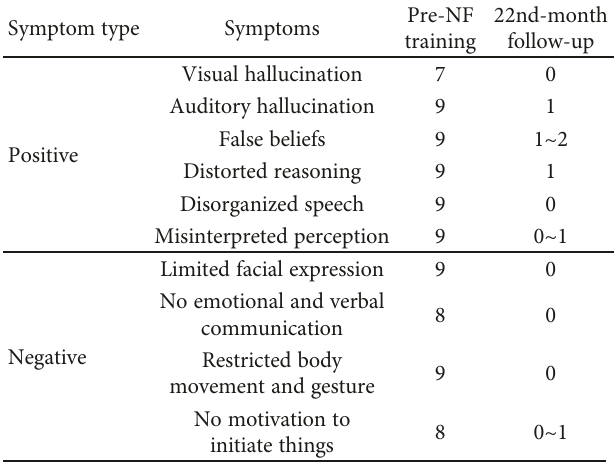
Table 1: Symptom